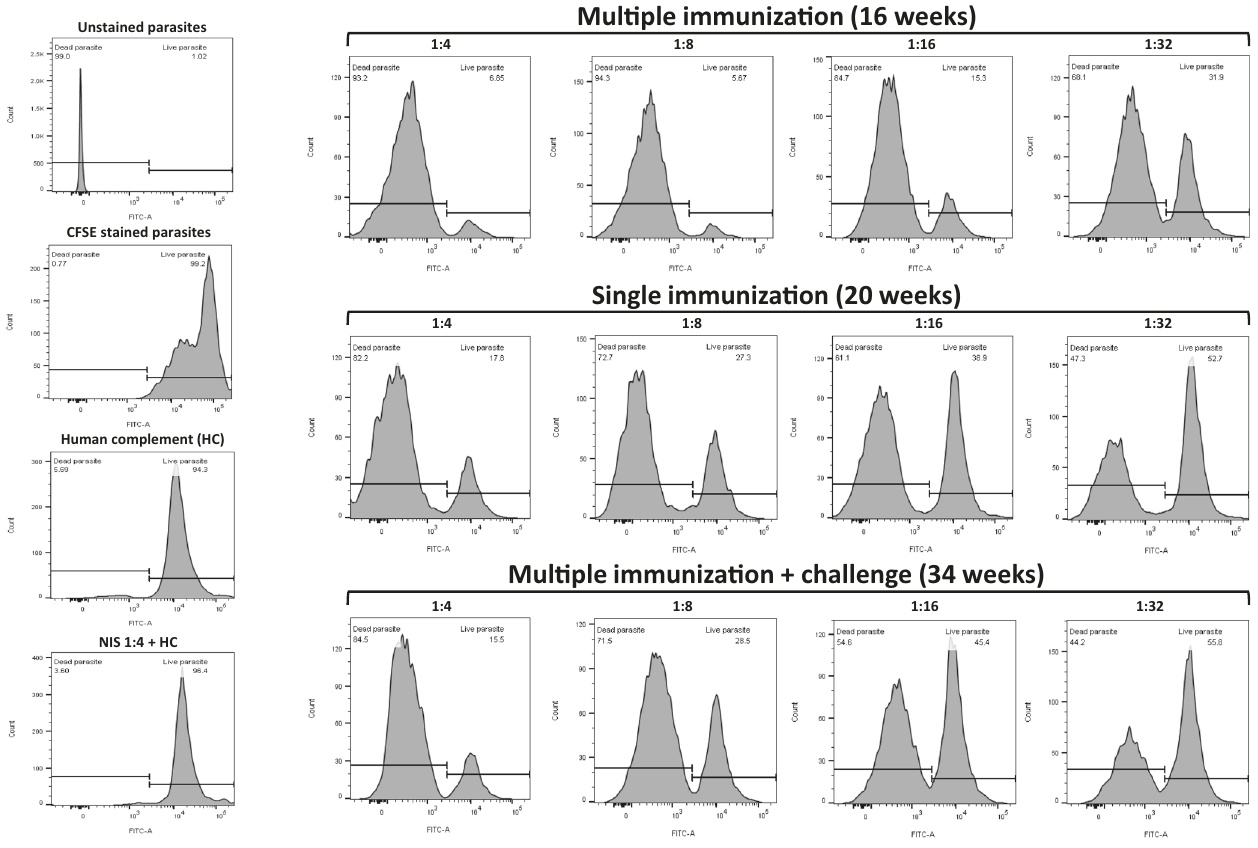
Fig. 6 Trypanolytic activity of immune serum from DKO-inoculated animals. Serum collected from animals which were inoculated multiple times (at 16 weeks from fi rst inoculation, upper right panel), after a single inoculation (at 20 weeks post inoculation, middle right panel) and after multiple immunizations WT + challenge (34 weeks after challenge, bottom right panel). WT RHM-derived trypomastigotes were used to analyze for the presence of Ab-mediated complement fi xing activity. Both serum from multiple and single administrations of DKO parasites were able to induce trypanolytic activity. Dilution of the serum resulted in incrementally less trypanolytic activity as expected. Control reactions (left panels) included non-stained parasites, CFSE-stained parasites alone, stained parasites incubated in human complement alone and those incubated in non-immune control serum + human complement. Sera were pooled from 3 – 4 mice per group prior to analysis. See Supplementary Fig. 11 for gating strategy for fl ow